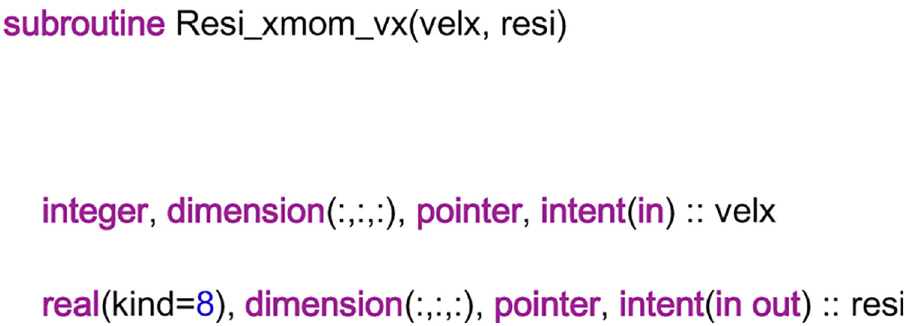
Fig 11. The head part of the code of the subroutine “Resi_xmom_vx”.